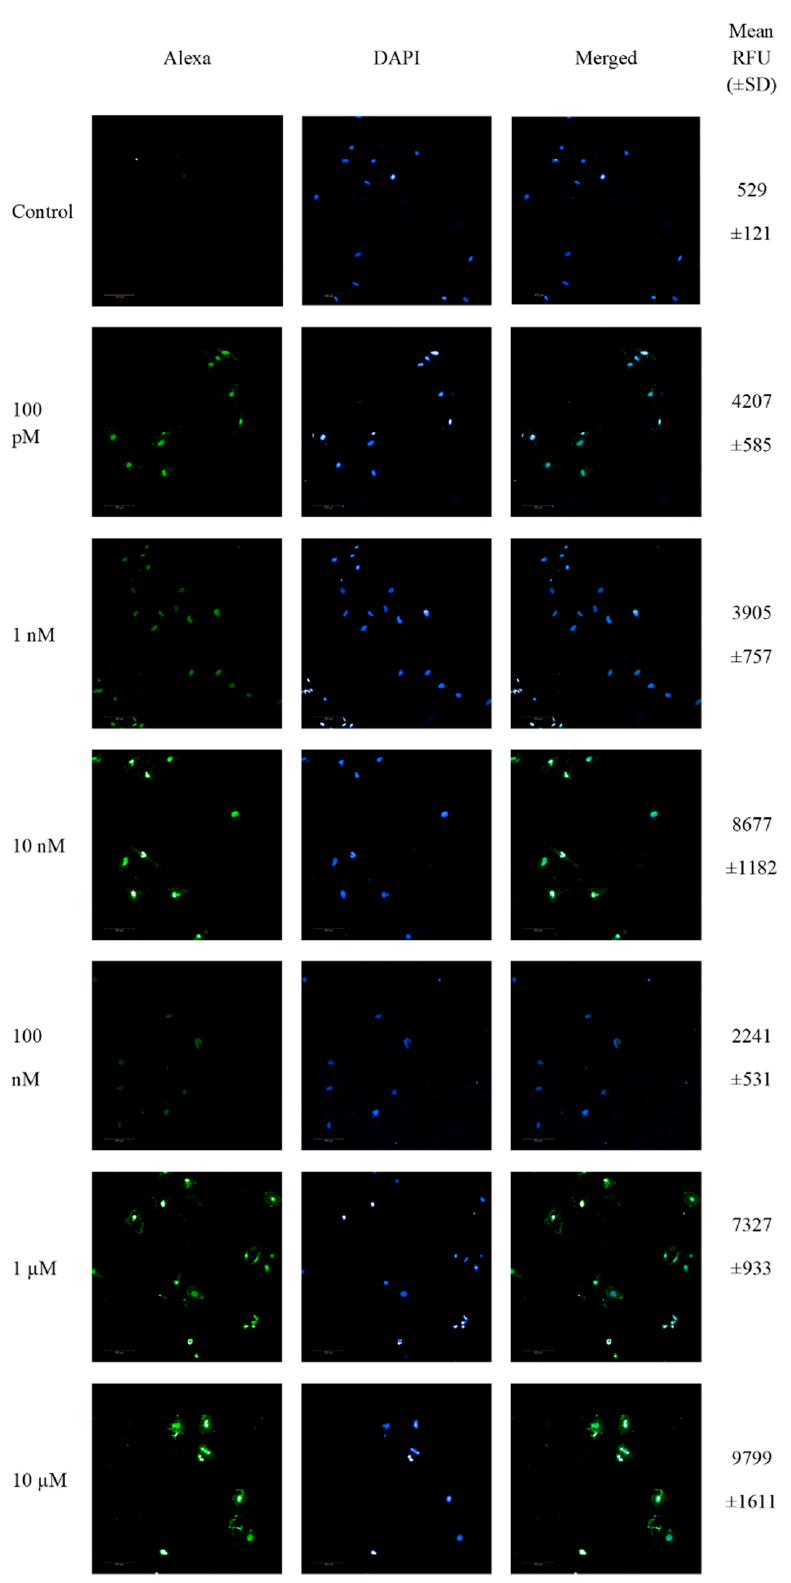
Figure 2. Confocal microscopy images of TUNEL assay. Detection of apoptotic cells based on DNA fragmentation labeling in the individual SW1088 cell line. FITC and DAPI staining for the nucleus. Representative images and the mean RFU values are shown.